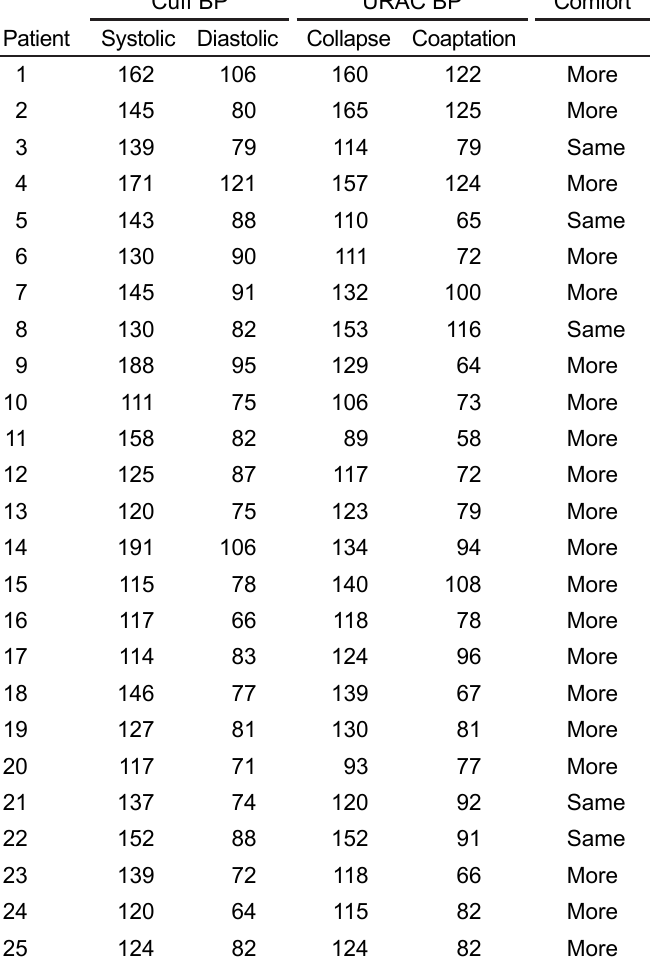
BP , blood pressure.